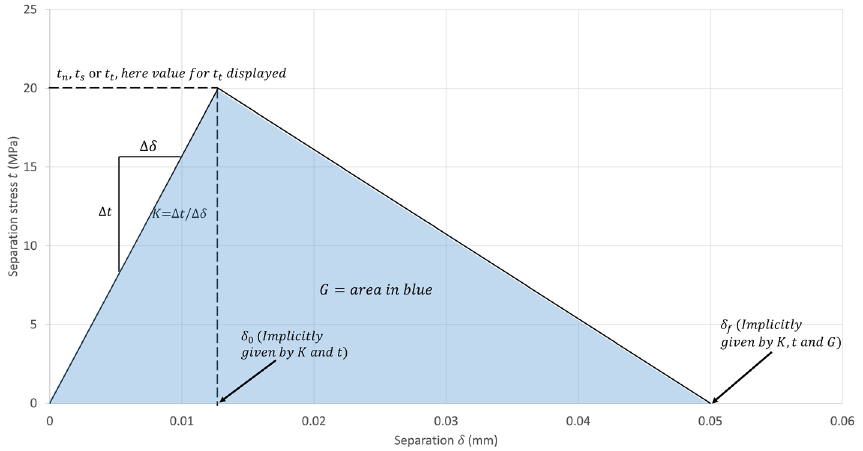
Figure 7. The shape and variables in the traction-separation response. The values on the axis are for the normal component in the traction separation contact definition.